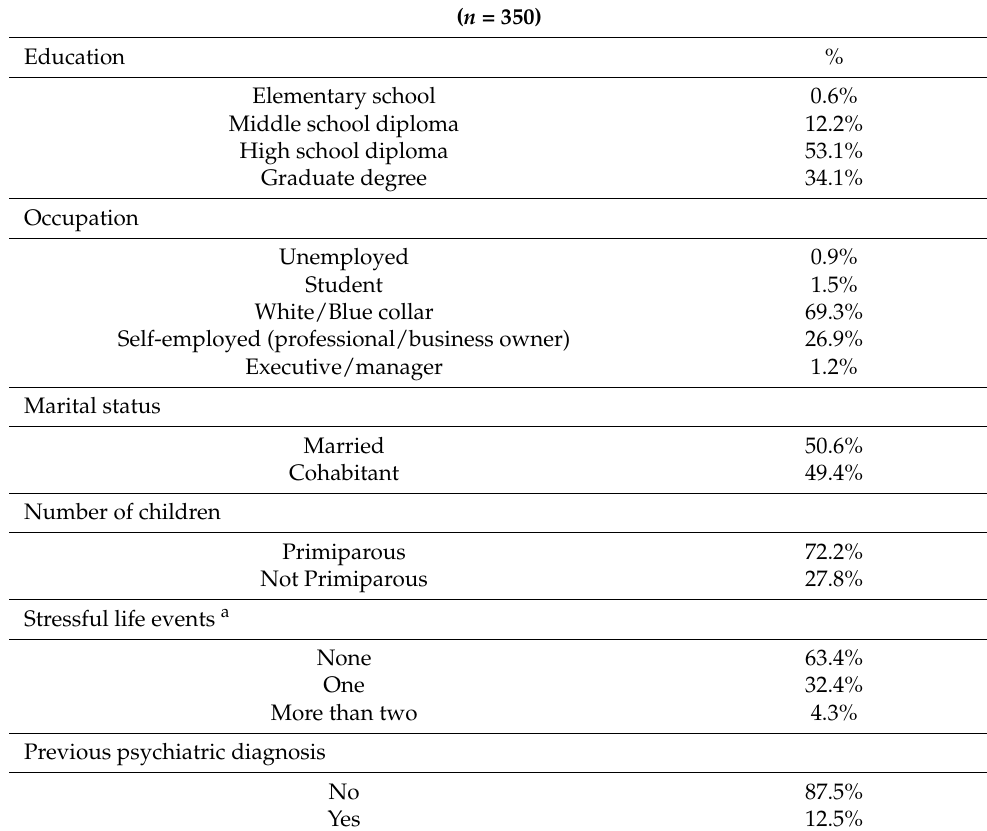
Table 1. Sample’s descriptive characteristics.